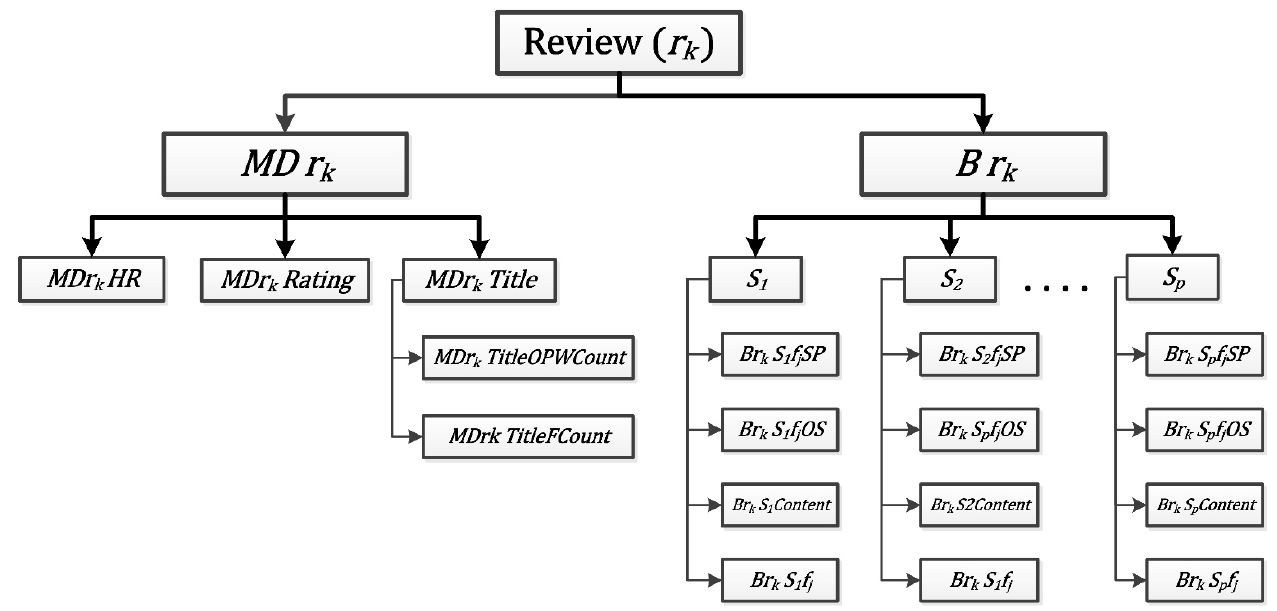
Figure 1. Hierarchy of the review tuple.